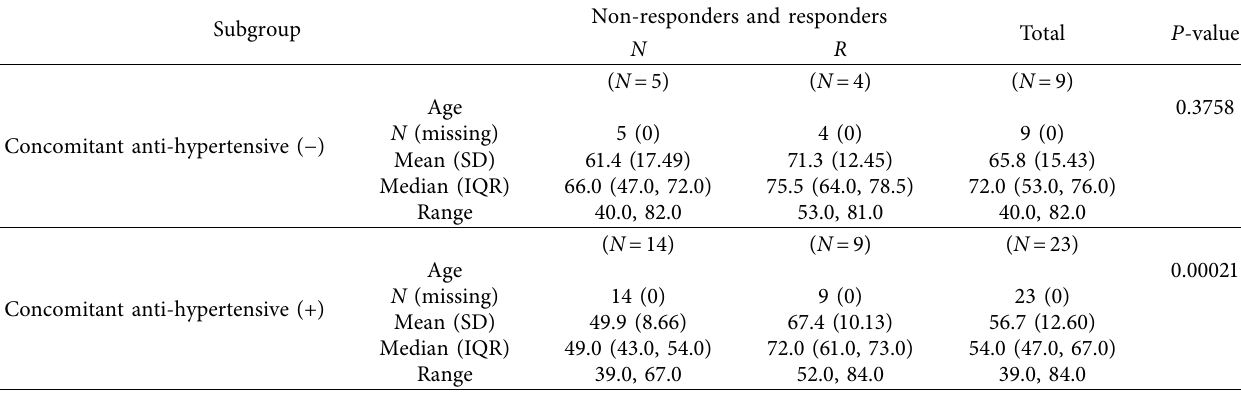
Table 4: Subgroup analysis; Concomitant of anti-hypertensive drugs.